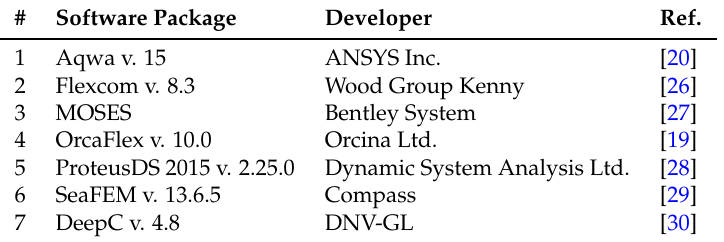
Table 1. List of relevant software to consider for dynamic mooring